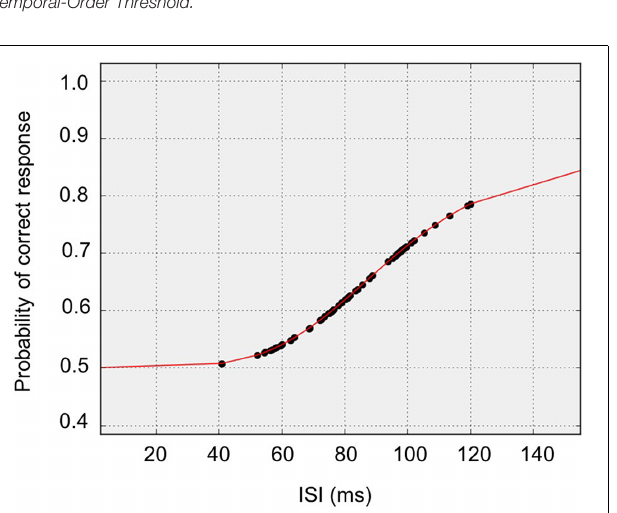
FIGURE 3 | Median subject data: typical responses and equation fit from an exemplar participant whose data was close to median